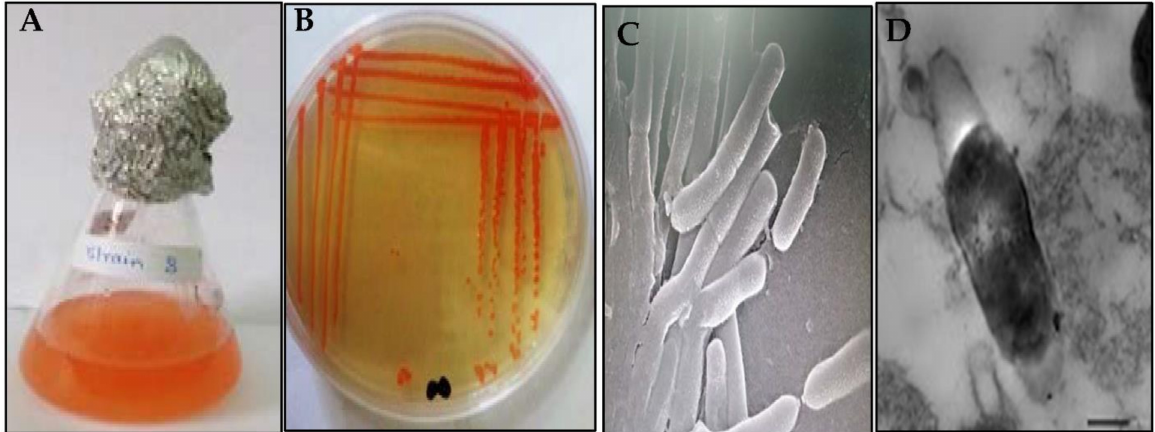
Figure 2. Cultural and morphological characteristics of V. halodenitrificans DASH. ( A ) Pigmented IRAM broth after one week incubation, ( B ) Small round orange colonies on IRAM agar, ( C ) Cell morphology by SEM and ( D ) Cell morphology by TEM showing central ellipsoidal